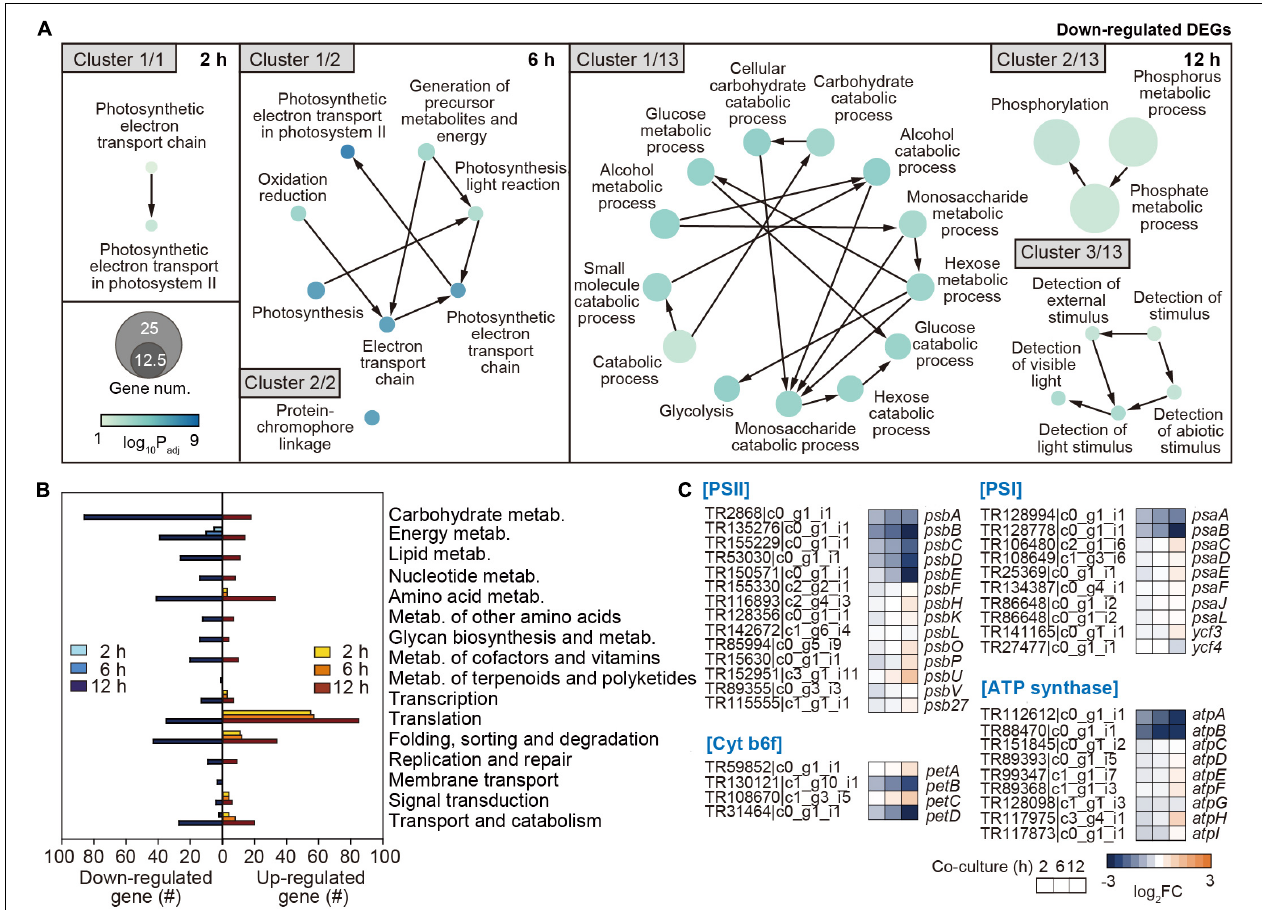
FIGURE 4 | Functional analysis of downregulated genes in A. catenella by co-culture. (A) Functional clustering through GO enrichment analysis was executed by co-culture time (2, 6, and 12 h) from downregulated DEGs in A. catenella , among which core clusters are displayed according to gene abundance. The node size indicates the gene number, and the color key indicates the log 10 p -value of DEG. (B) KEGG analysis results from the DEGs in A. catenella are also shown by co-culture time. (C) Transcriptome changes after co-culture in the genes of photosystem II (PSII), cytochrome b6f, PSI, and ATP synthase in the oxidative phosphorylation pathway are displayed using a heatmap, according to the co-culture time. FC indicates the fold change in transcriptome after